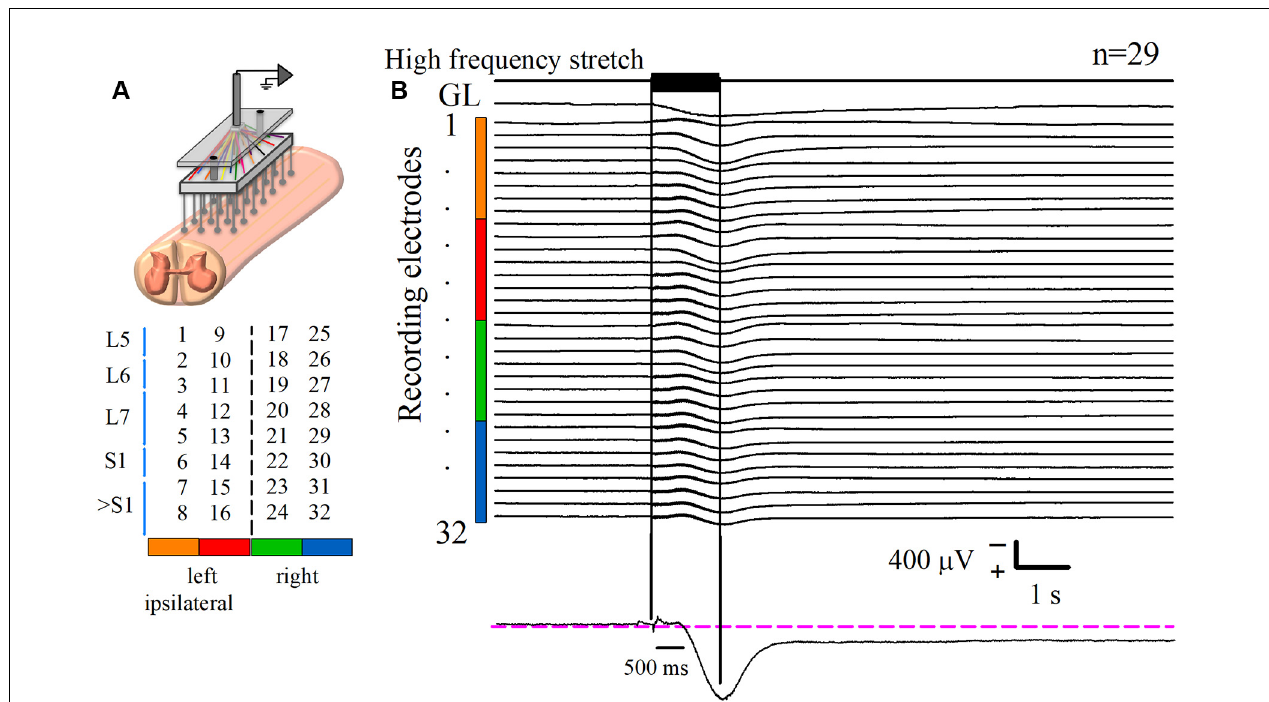
FIGURE 1 | Recording of the DC potential on the spinal cord dorsum in response to a high-frequency stretch stimulus applied to the Achilles tendon. (A) Scheme of the recording paradigm, which consisted of an array of 32 (8 × 4) Ag-AgCl spherical electrodes positioned over the surface of the lumbosacral spinal cord. The array was coupled to a Synamps amplifier system in DC mode. The midline is represented by the dashed line that divides the two halves of the array. Spinal segments are specified at the left, according to Marcoux and Rossignol (2000). (B) The first upper trace is the high-frequency stretch stimulus applied on the left Achilles tendon. The two vertical black lines indicate the duration of such stimulus. The trace labeled with gastrocnemius lateralis (GL) is the rectified and integrated electroneurographic (ENG) signal recorded from the GL nerve. See how the GL activity experiences a sustained rise following the stimulus. The next 32 traces are the averaged DC potentials recorded from the spinal cord dorsum after several trials ( n = 29) of stimulation. Such signals were obtained from the electrode array represented in (A) ; see color code. Note the marked positive DC shift that outlasts the mechanical stimulus duration for 6.4 ± 0.3 s (mean ± standard error). Observe that the sustained slow DC potential in the cord dorsum occurs concomitantly with the GL ENG activity. The recording in the lower panel is a zoom of a slow DC